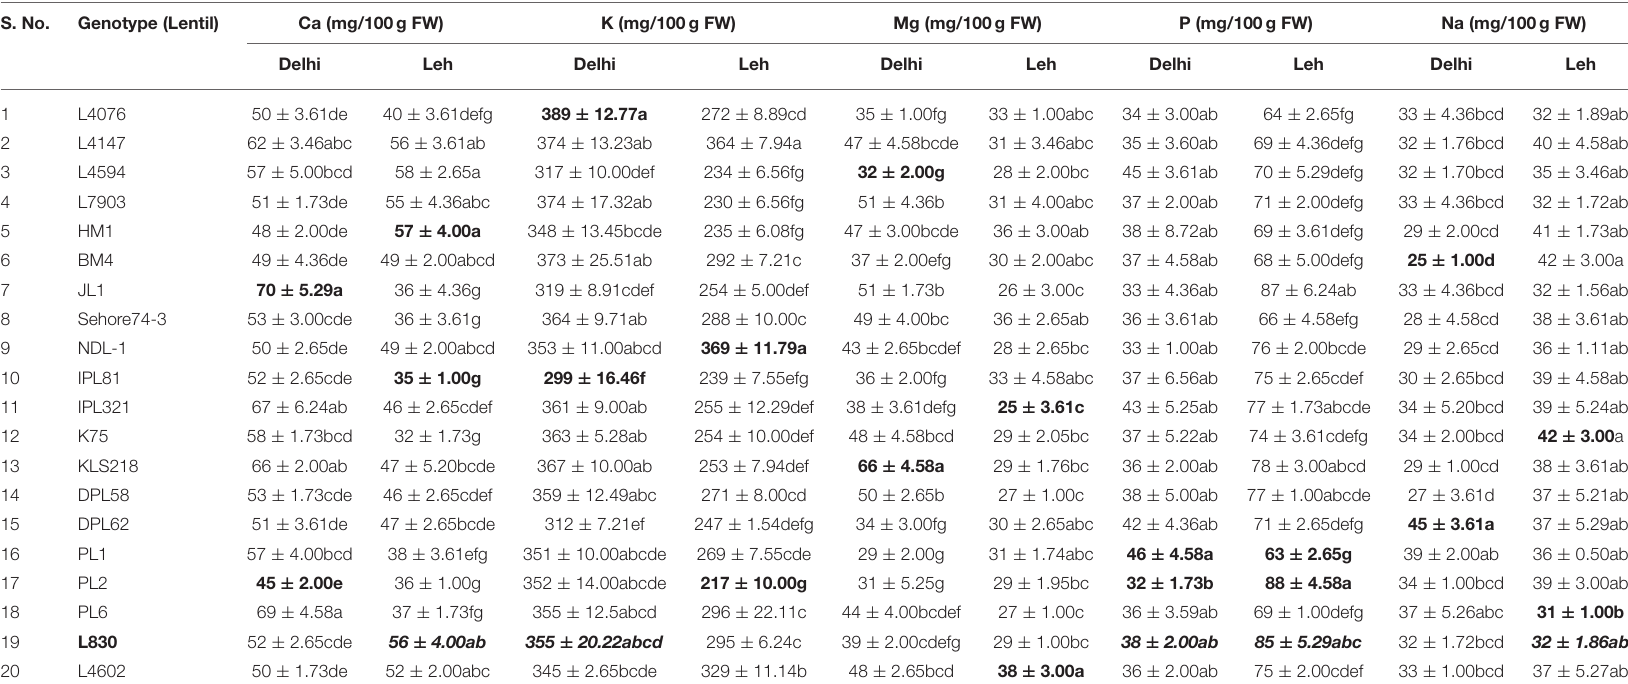
TABLE 9 | Macro-nutrient content in various lentil microgreens grown at Delhi and Leh conditions. S.